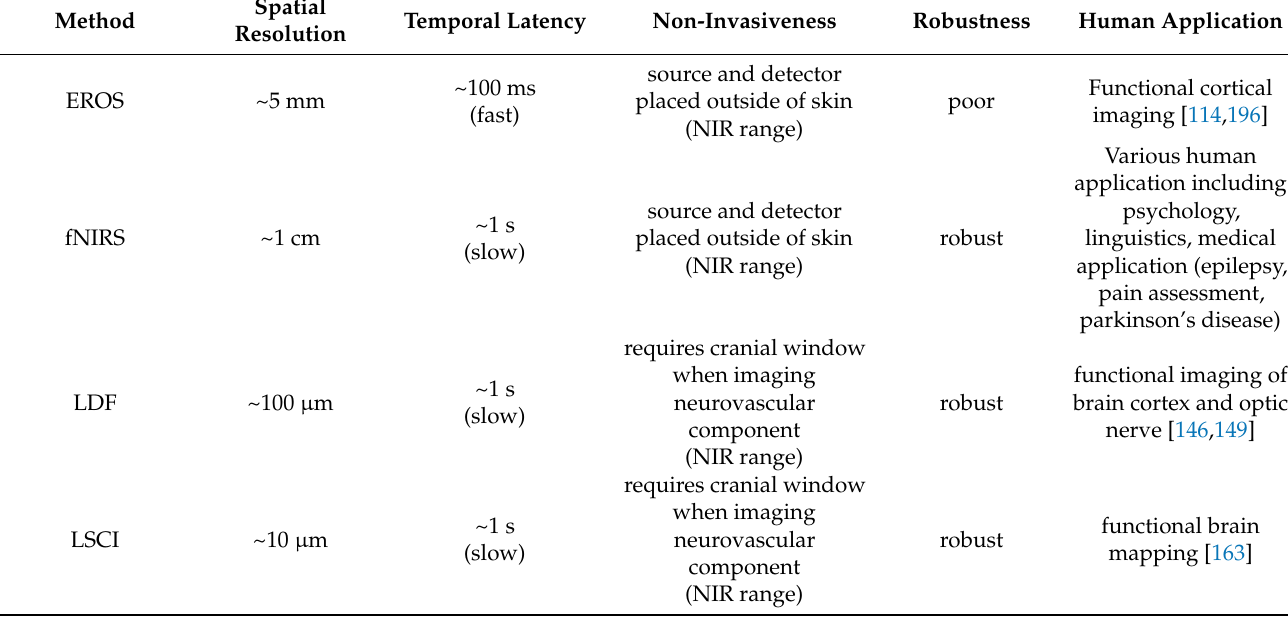
Table 2. Optical neural interface for reading out the neural